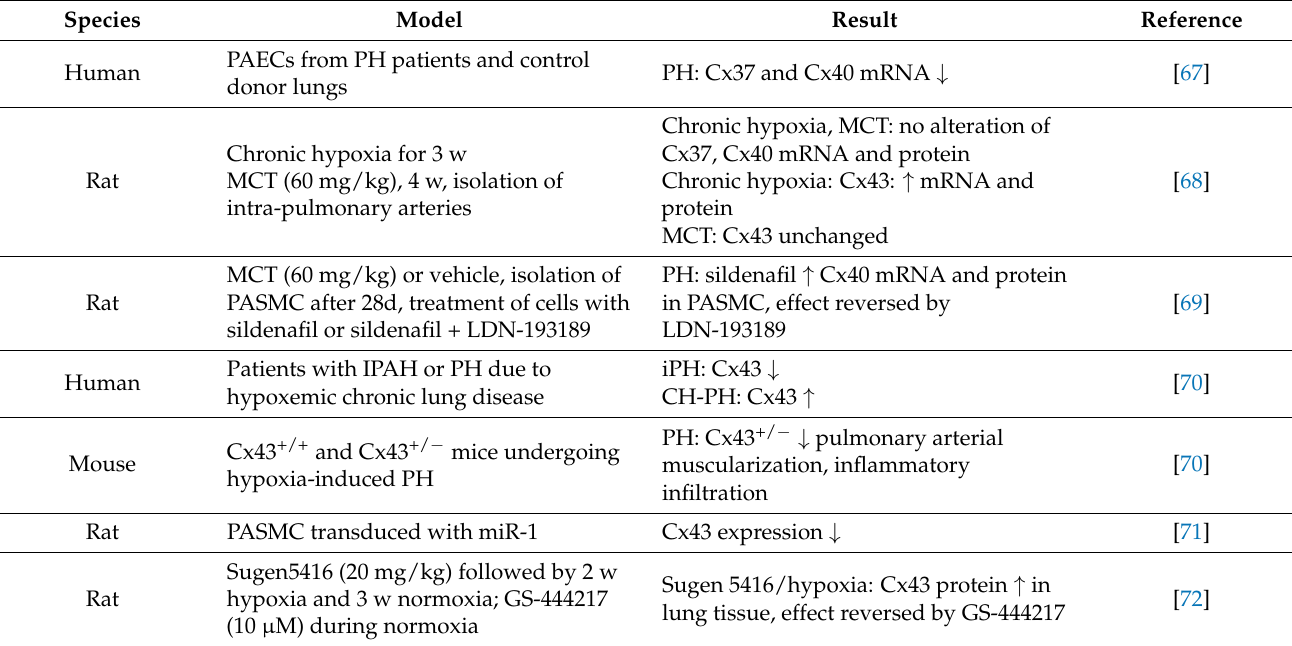
Table 3. Pulmonary hypertension: connexins in vascular